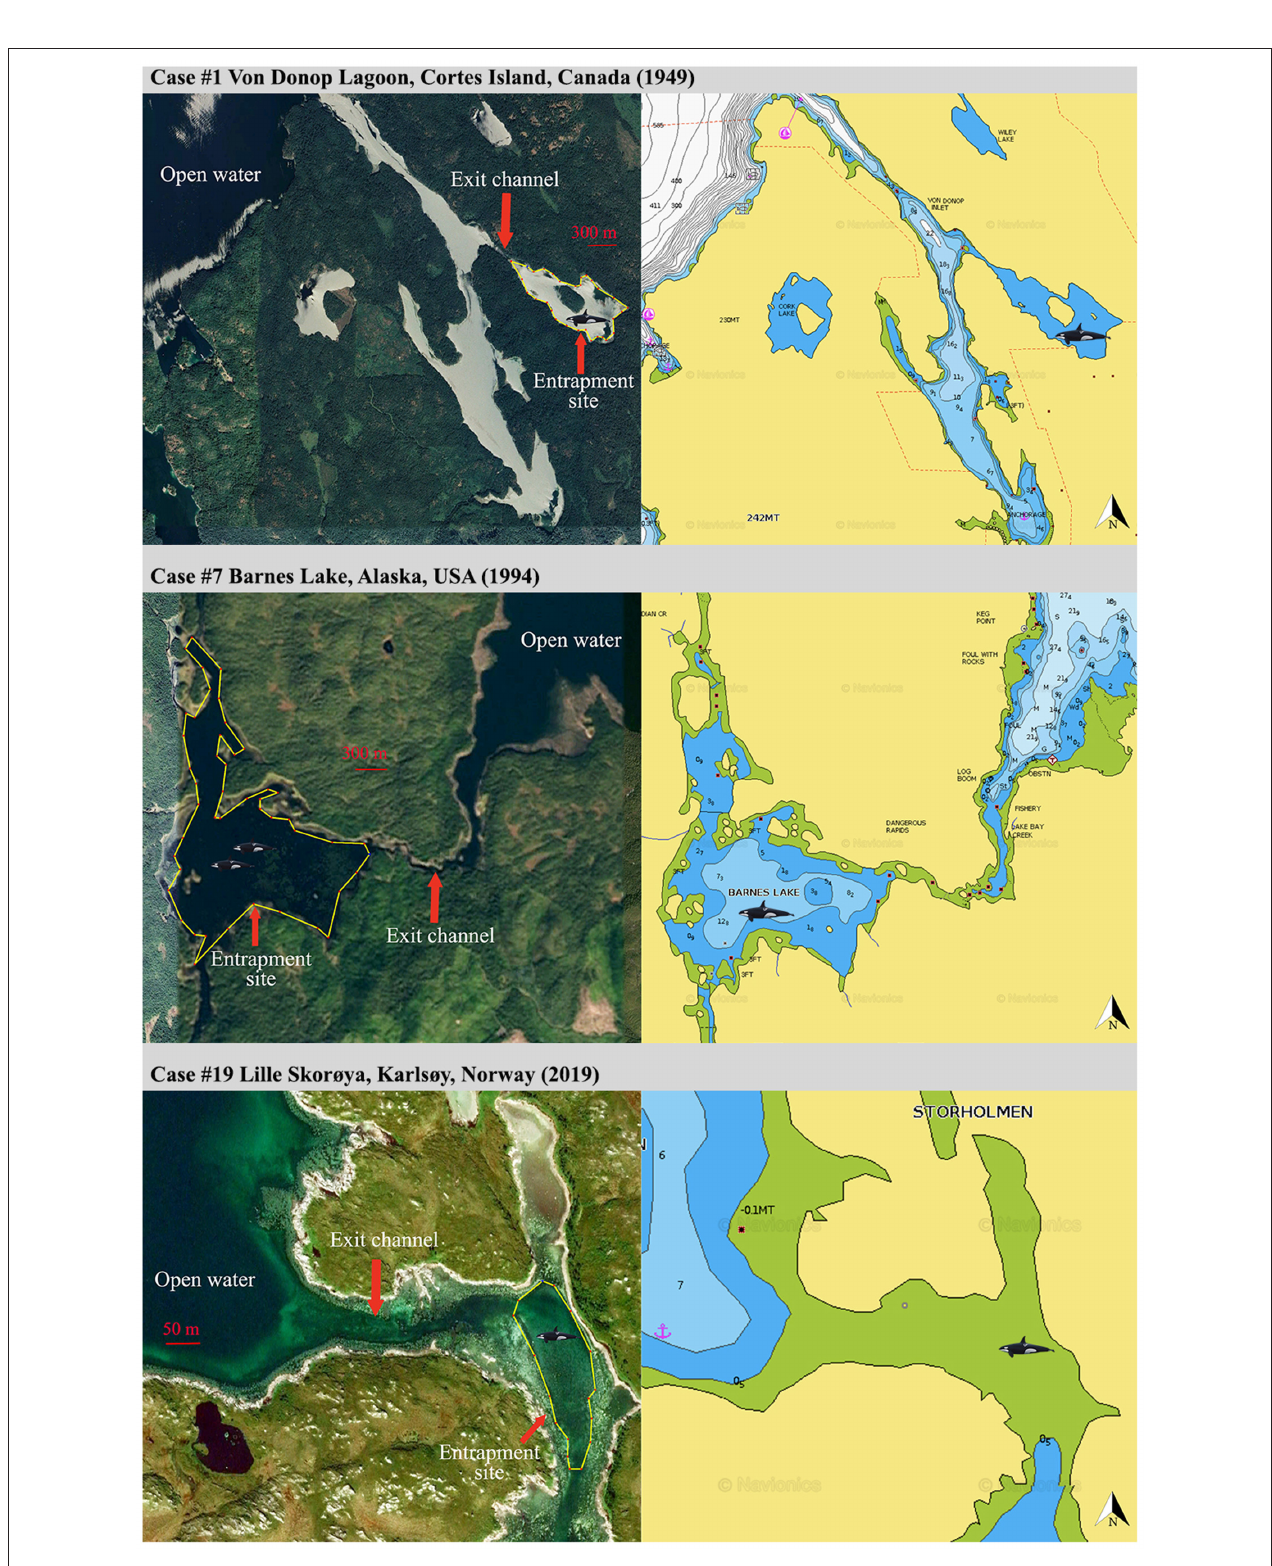
FIGURE 1 | General site configuration (left panels, screengrabs from Google Earth, https://www.google.com/earth/) and corresponding bathymetry (right panels, screengrabs from Navionics, https://www.navionics.com) revealing geographical constraints for a sample of three entrapment cases of Category 1 .